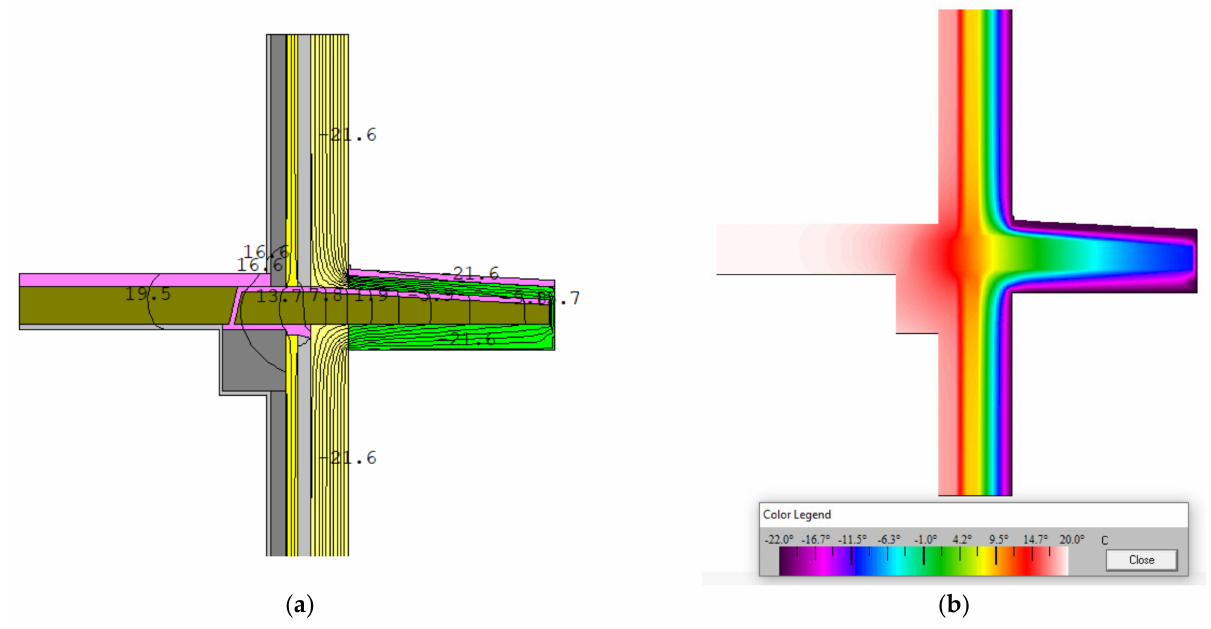
Figure 8. Temperature field in cross-section for scenario III B, wall with 15 cm thick insulation: ( a ) isotherms ( b ) colour scale.